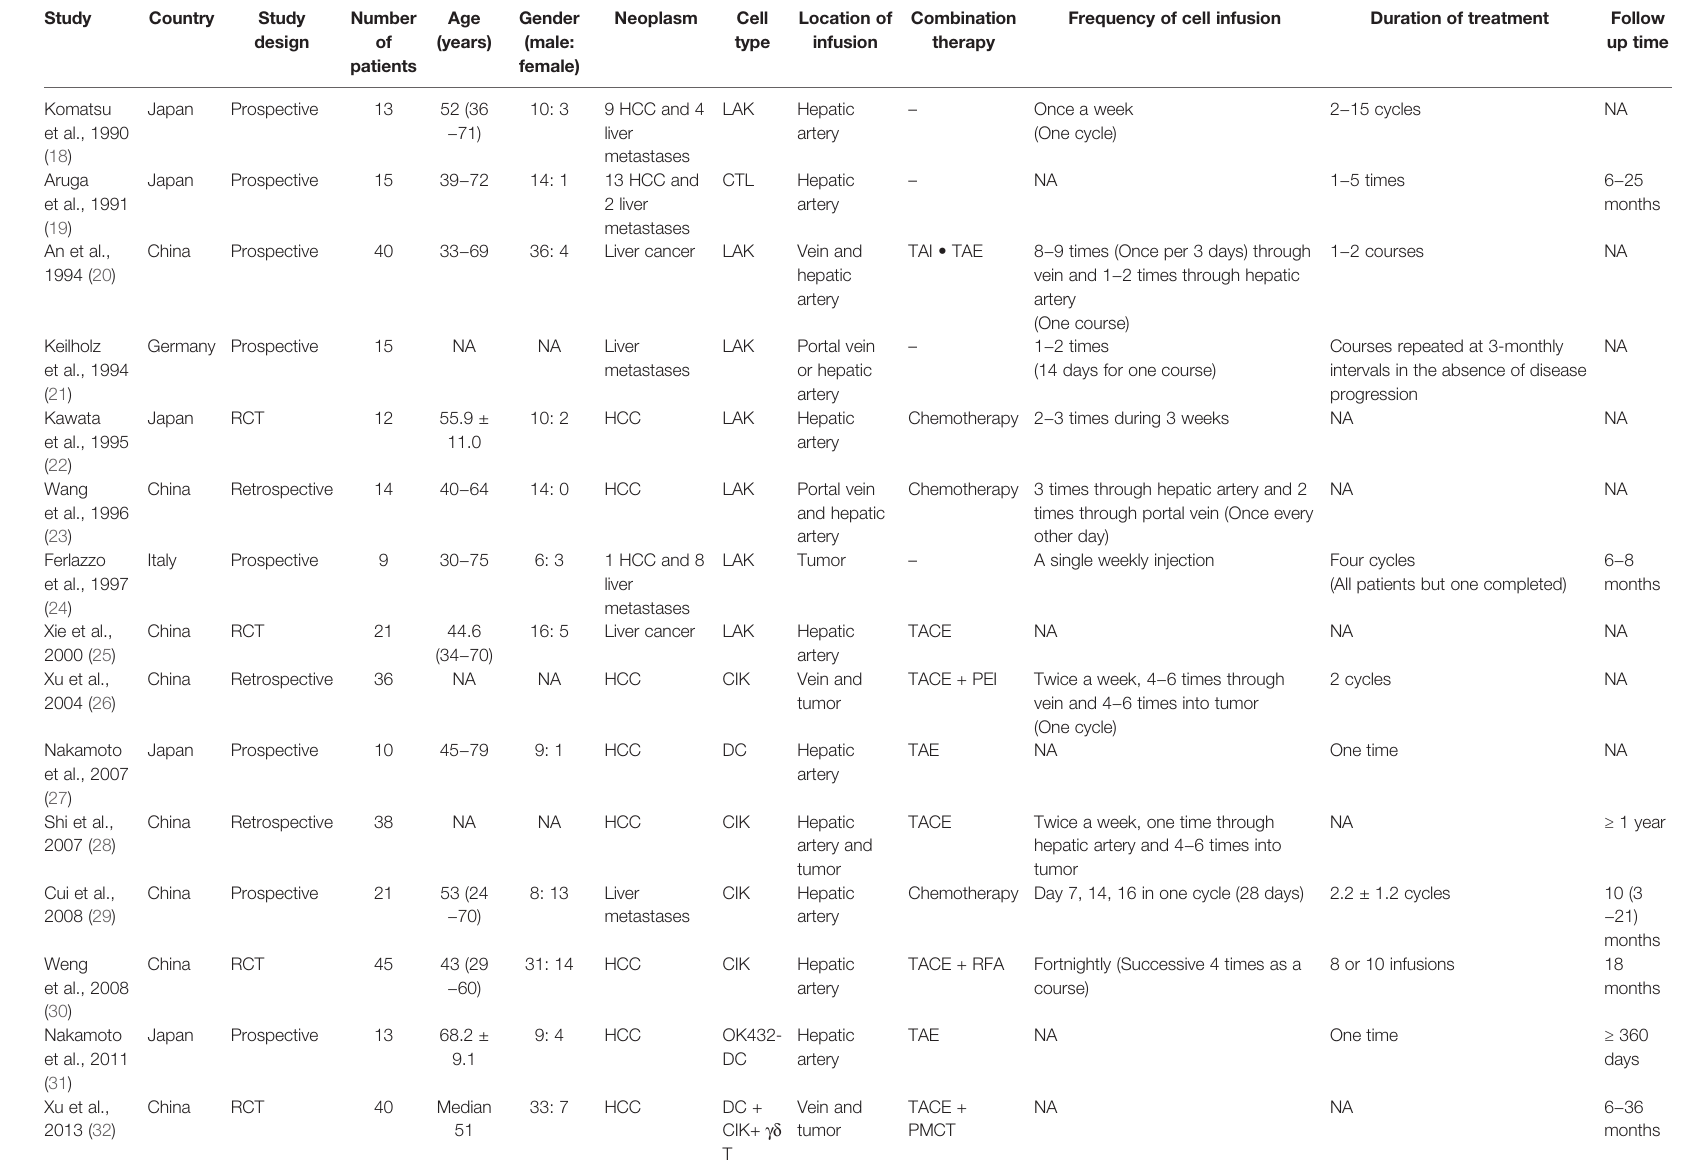
TABLE 2 | Characteristics of included